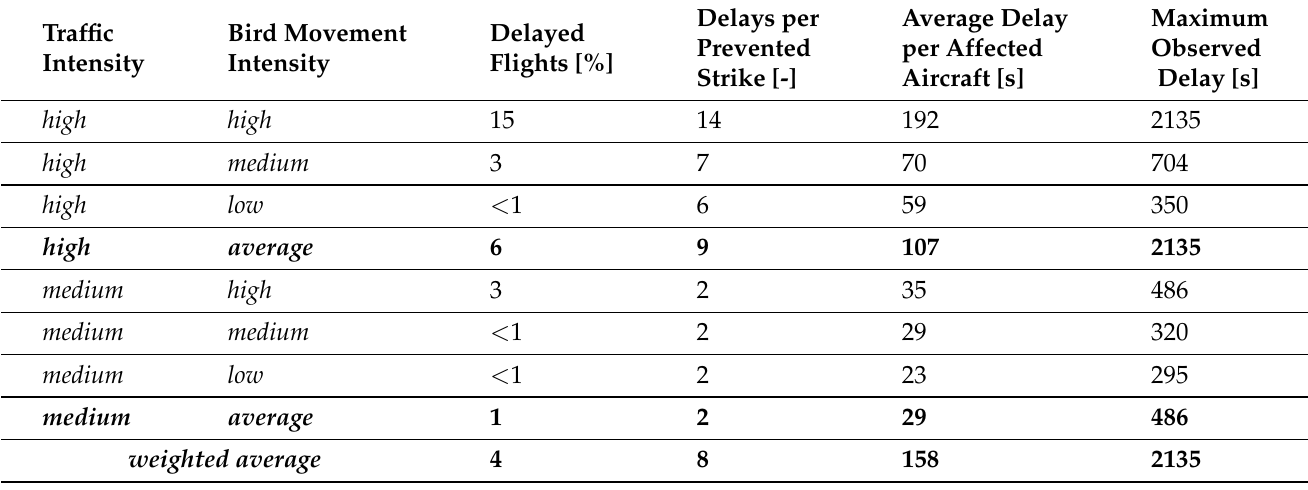
Table 3. Overview of delays resulting from the intervention of the collision avoidance algorithm per individual scenario, averaged per air traffic intensity as well as averages weighted by number of flights over all scenarios.